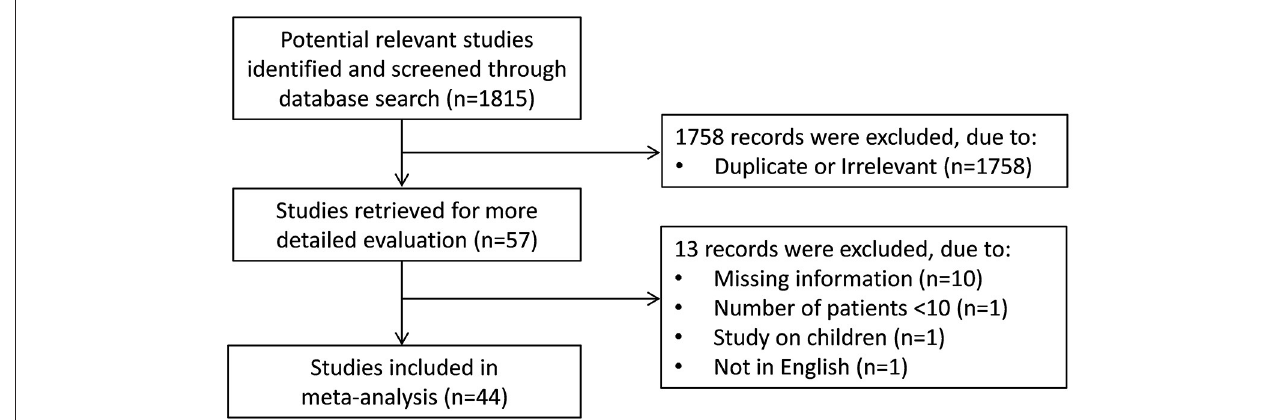
FIGURE 1 | Study selection flow